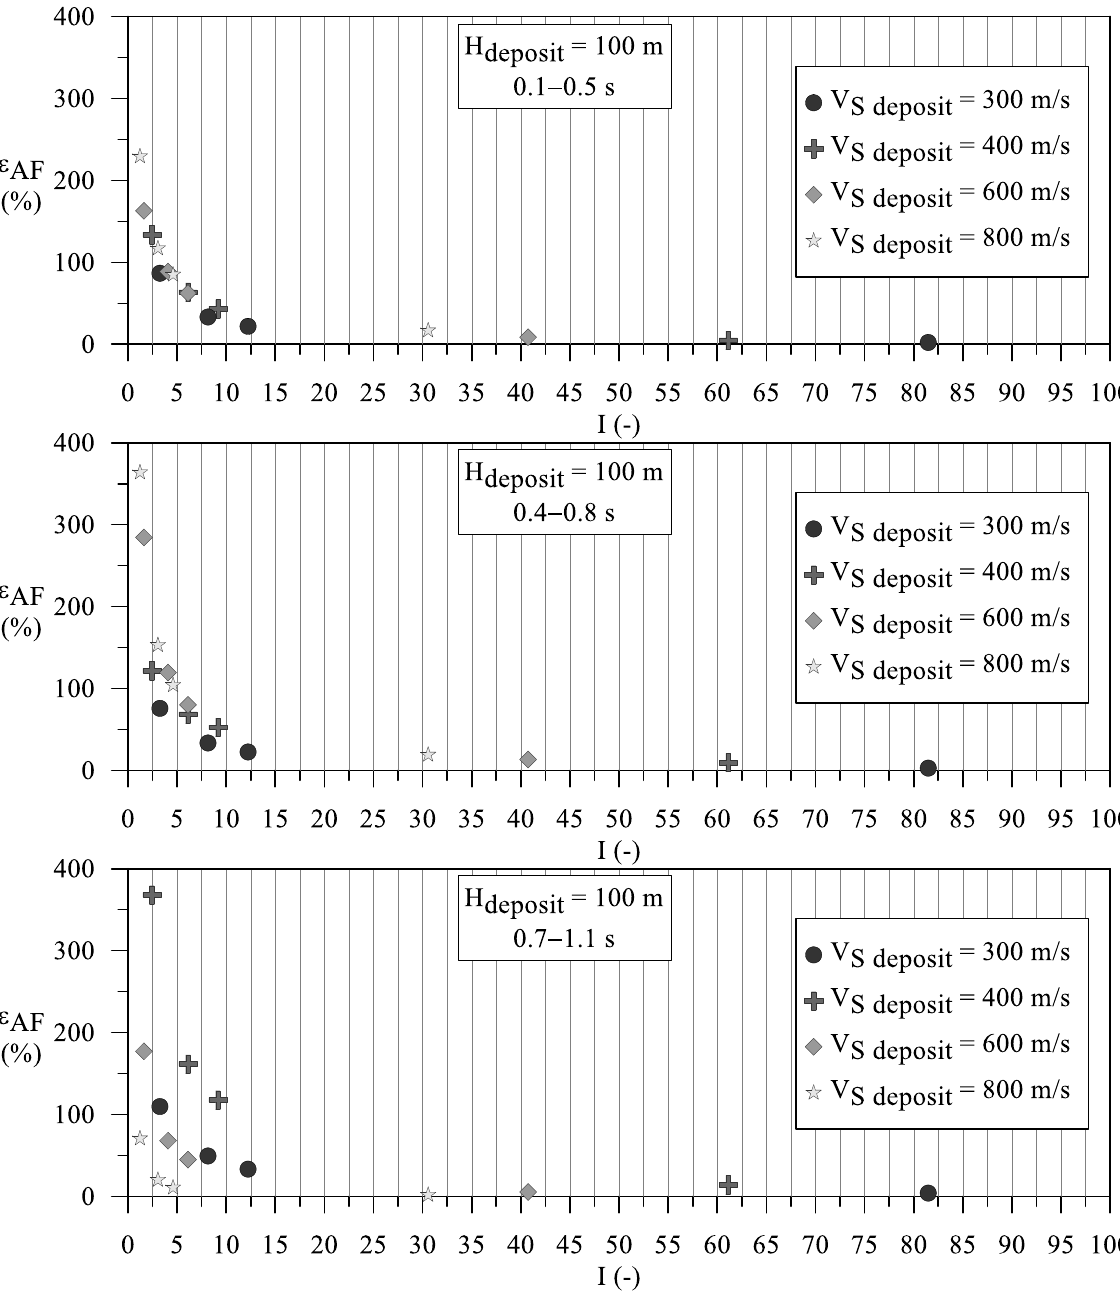
Figure 5. Error in the estimation of AFs quantified according to Equation (2), with reference to cover deposit thickness equal to 100 m and linear visco-elastic materials. In detail, assuming V S = 20,000 m/s for the half-space, the impedance contrast results equal to 81.5, 61.1, 40.7, and 30.6 with reference to deposit V S equal to 300, 400, 600, and 800 m/s, respec- tively.